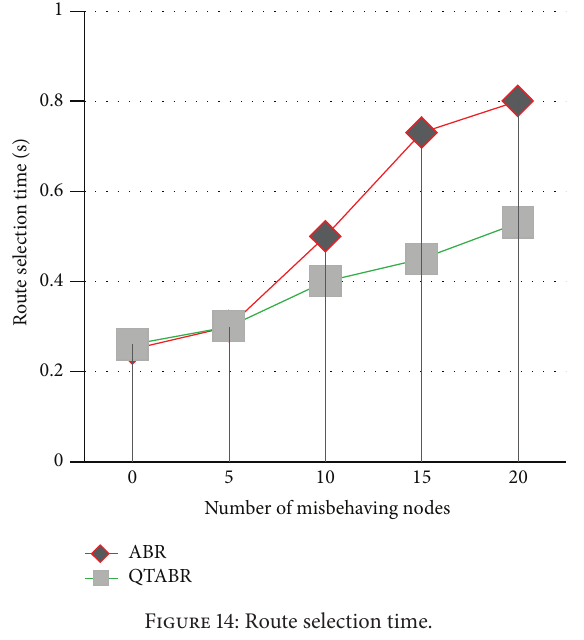
Figure 14: Route selection